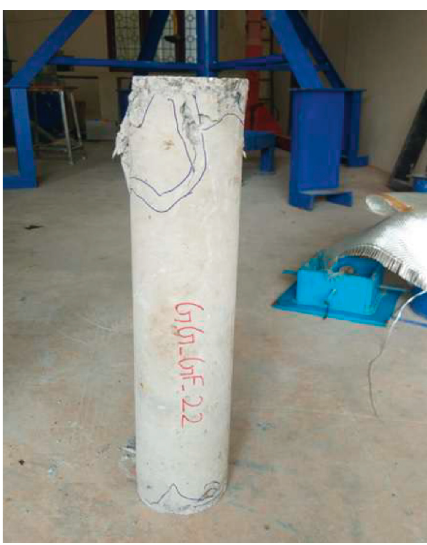
Figure 11: Column after being subjected to damage.